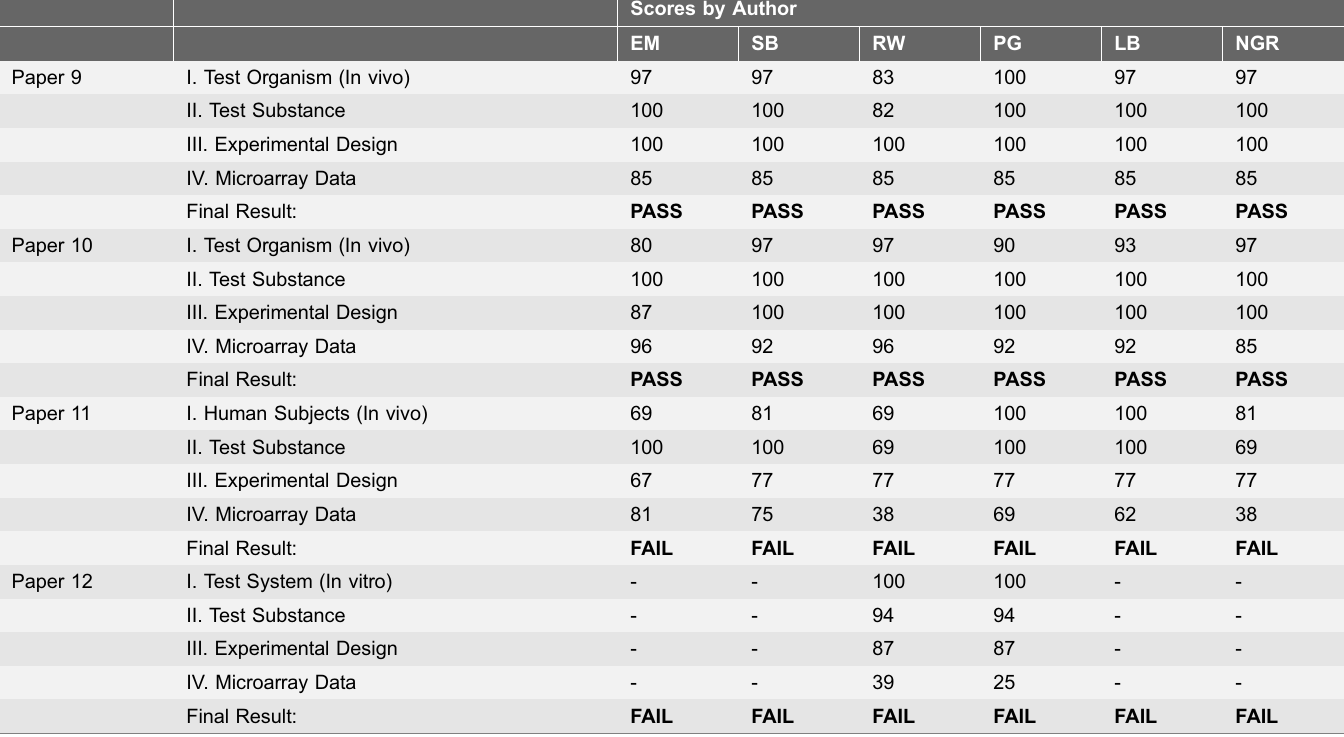
Table 4. Results from Round 4 of